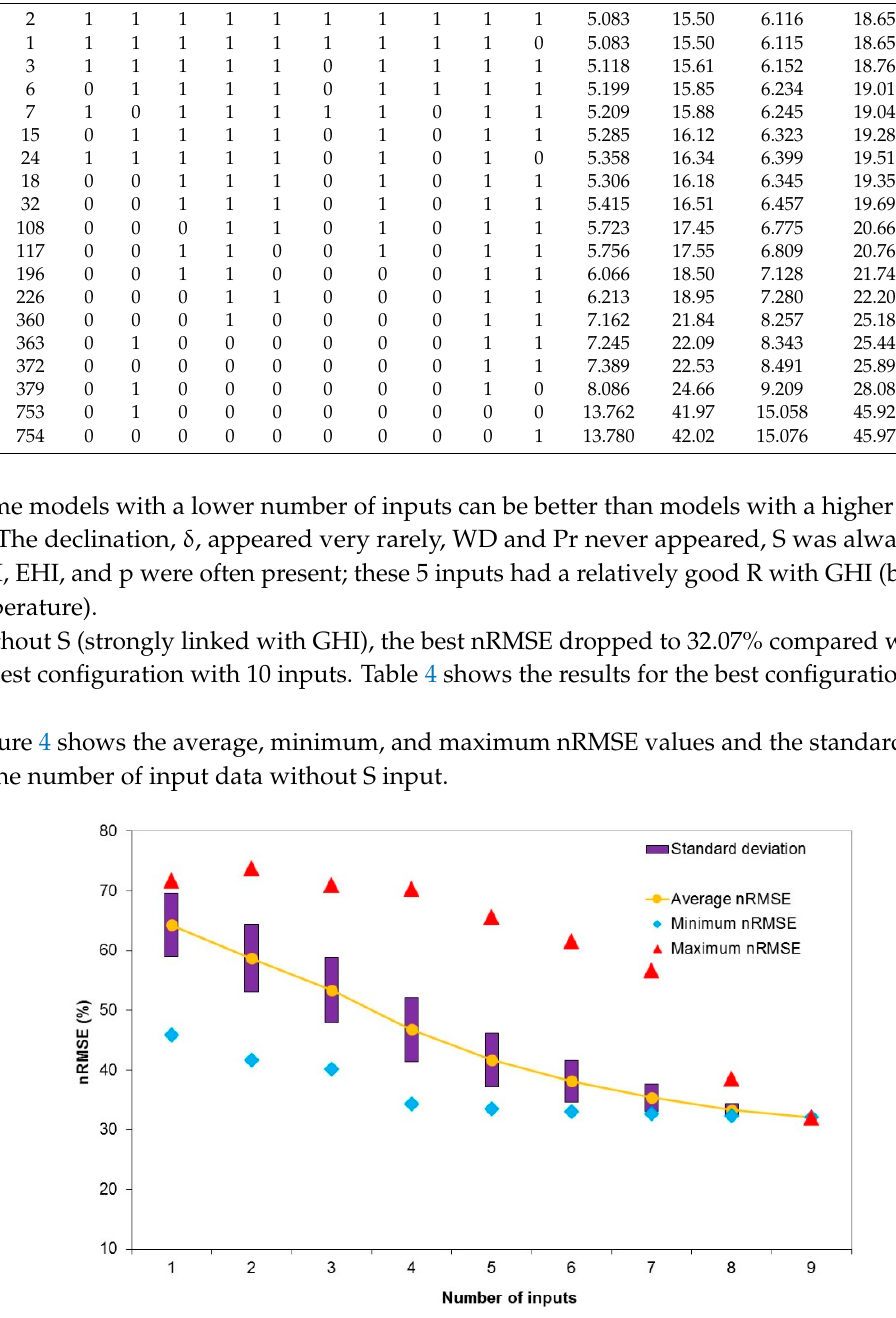
Figure 4. Average, minimum, and maximum values of the nRMSE and its standard deviation versus the number of inputs without S as input (Bouzareah site). Table 4. Best configurations according to the number of inputs (without S) (Bouzareah site). (1 = present data, 0 = absent data).